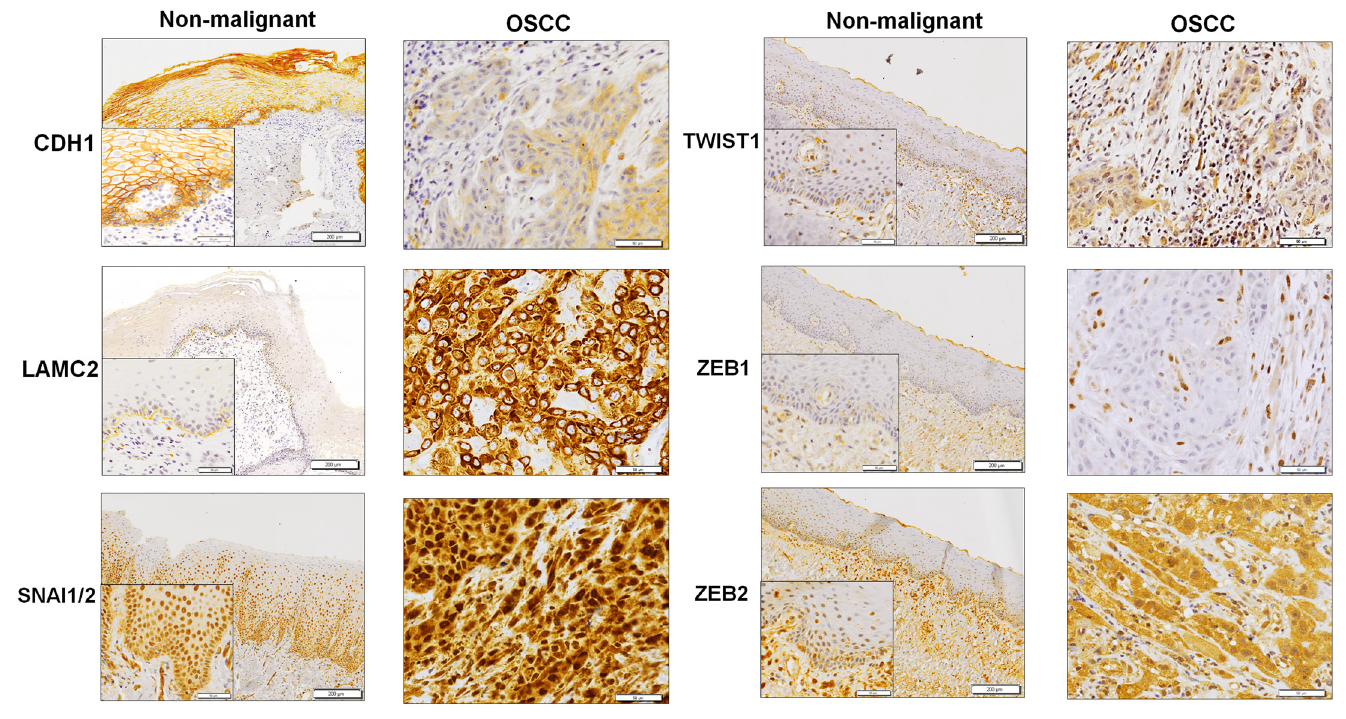
Fig 1. Representative immunostaining of EMT-related markers in non-malignant oral mucosa (Original magnification: 40X, 200X-Inset) and oral squamous cell carcinoma tissues (OSCC; Original magnification: 200X).